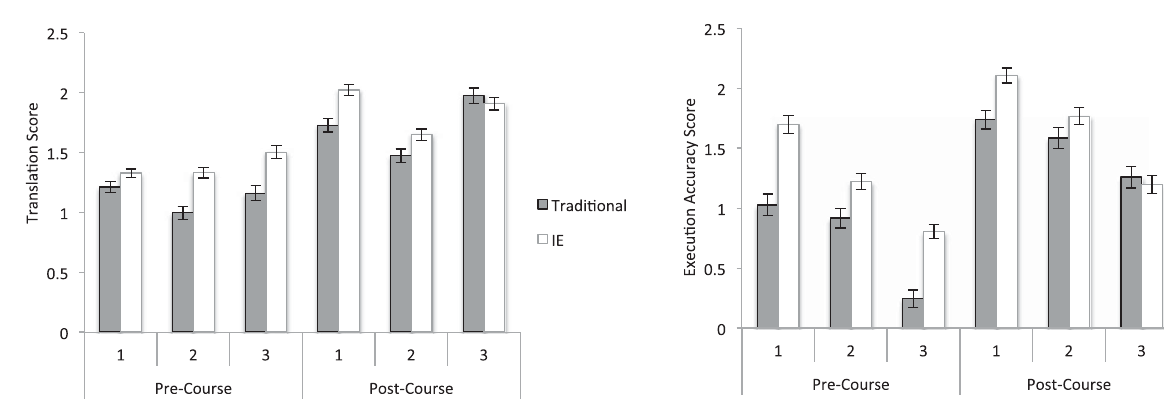
FIG. 2. Pre- and postcourse translation score as a function of problem number and class format (total possible score ¼ 3 ). Error bars represent the standard error.